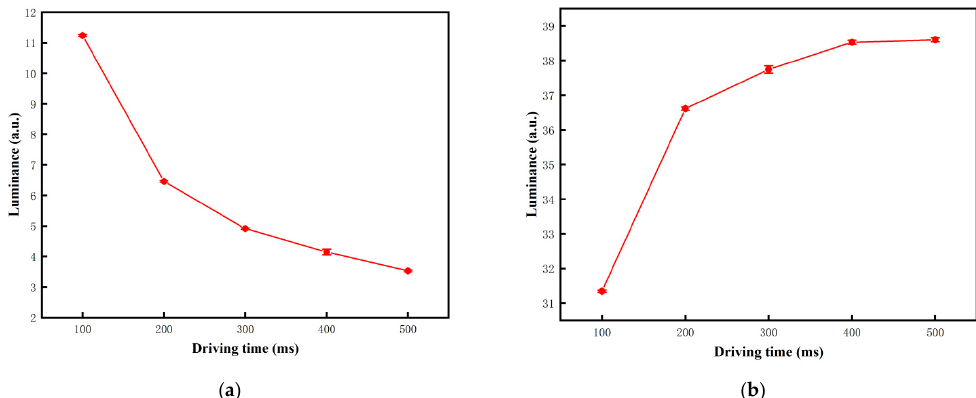
Figure 7. The relationship between luminance and the duration of white or black driving stage. ( a ) The luminance when the target grayscale was black and the minimum luminance was 3.53 when the duration was 500 ms. ( b ) The luminance when the target grayscale was white and the maximum luminance was 38.6 when the duration was 500 ms.